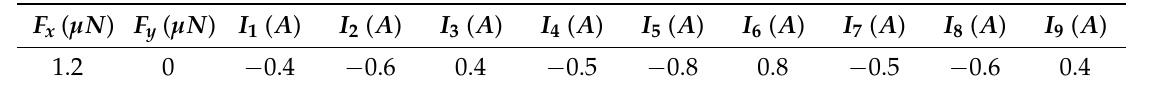
Figure 6. Autonomous navigation of three robots under the influence of local magnetic fields generated with the array of 64 microcoils: ( a ) collision free waypoints computed by planner (the action set consists of four linear actions (top, bottom, right, and left)); ( b ) paths followed by the controller with the presence of measurement noise. Table 2. Optimization